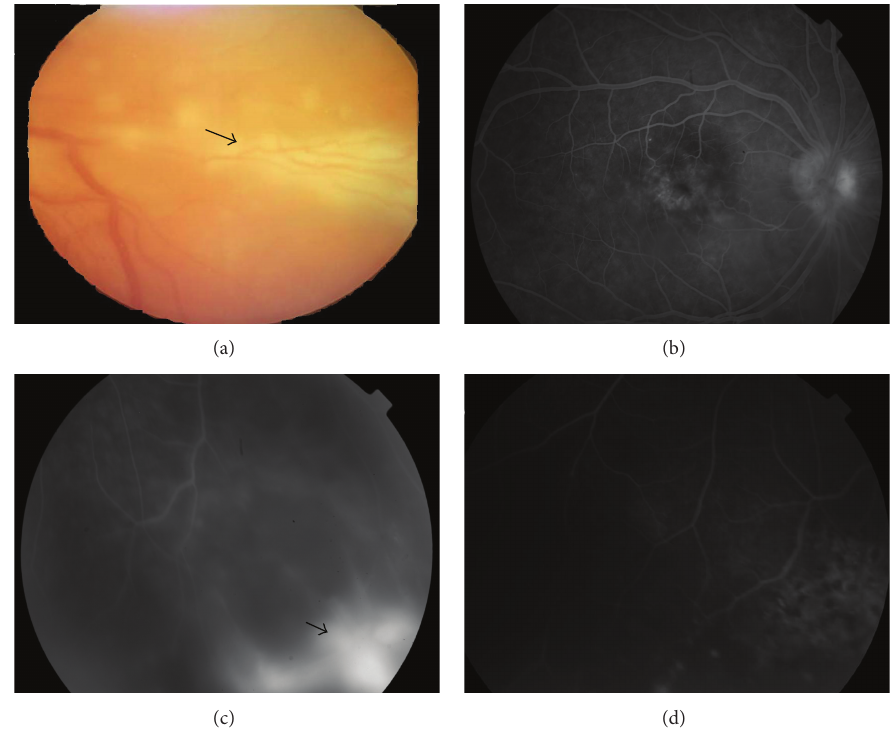
Figure 6: (a) Color fundus imaging of retinal vasculitis secondary to sarcoidosis showing perivenous exudates, “candle wax drippings.” (b) Fundus fluorescein angiography of an eye with ischemic vasculitis secondary to sarcoidosis shows leakage at macula secondary to macular edema; (c) peripheral retinal hypoperfusion with focal area of fluorescein leakage corresponding to new vessel formation (arrow). (d) Image taken five months following treatment with systemic corticosteroids and focal laser photocoagulation shows regression of the neovascularization.